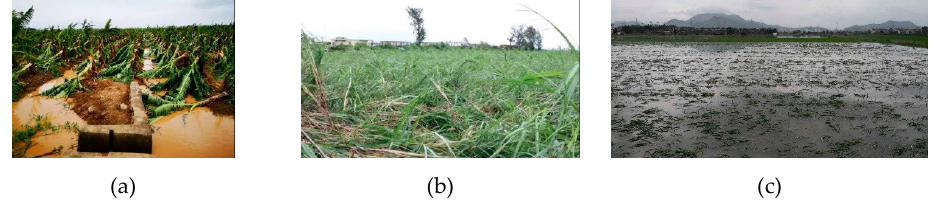
Figure 1. Pictures of vegetation damage (VD) induced by Mangkhu in 2018 ( a ) and ( b ) are from http://news.sina.com.cn/o/2018-09-19/doc-ihkhfqns8435454.shtml, ( c ) is from http://www.weather.com.cn/zt/tqzt/2930932.shtml).